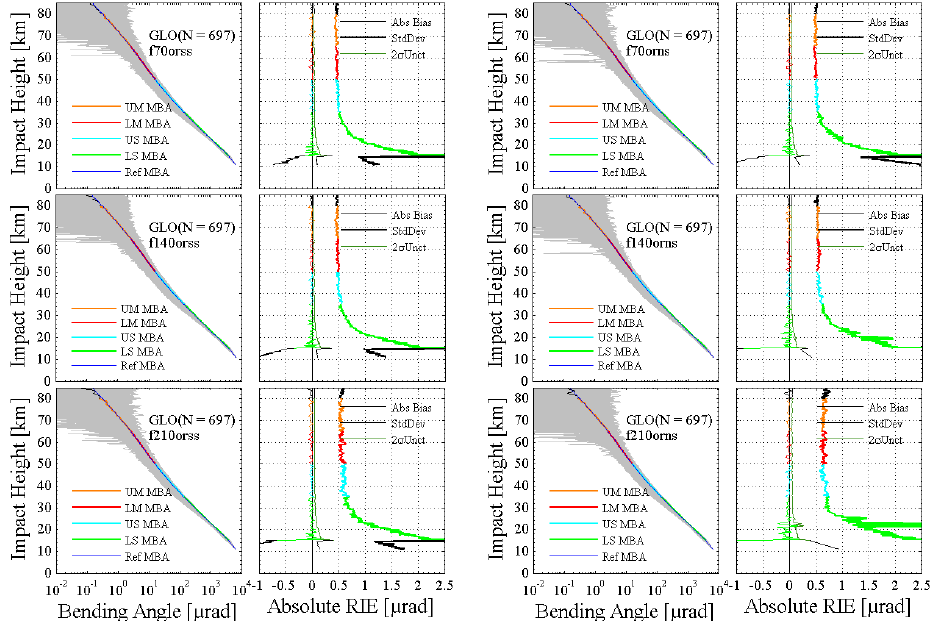
Figure 9. Ionosphere-corrected bending angle profiles and their statistical results for the GLO “orss” (left) and “orns” (right) data sets. The figure layout and legends are the same as in Fig. 6.